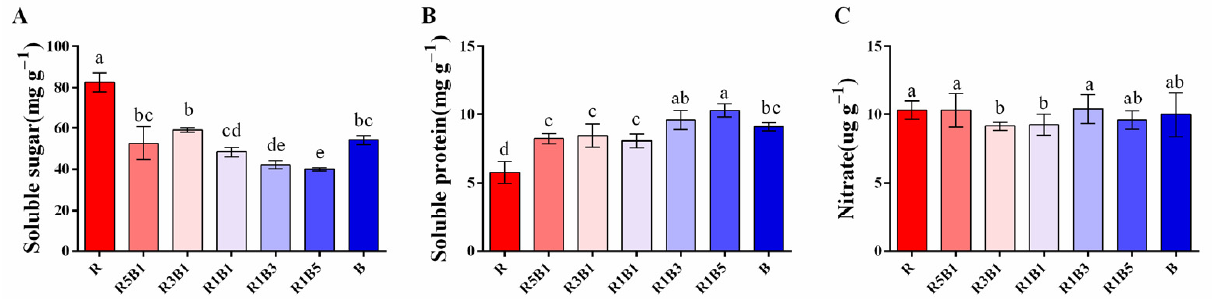
Figure 9. Soluble sugar ( A ), soluble protein ( B ), and nitrate levels ( C ) of coriander plants under various R and B light intensities. Bars represent the mean ± SD ( n = 3). According to one way ANOVA, different letters denote statistically significant differences between treatments (Duncan’s test, p < 0.05). R: monochromatic red light; R1B5: red to blue ratio = 1:5; R1B3: red to blue ratio = 1:3; R1B1: red to blue ratio = 1:1; R1B3: red to blue ratio = 1:3; R1B5: red to blue ratio = 1:5; B: monochro- matic blue light.